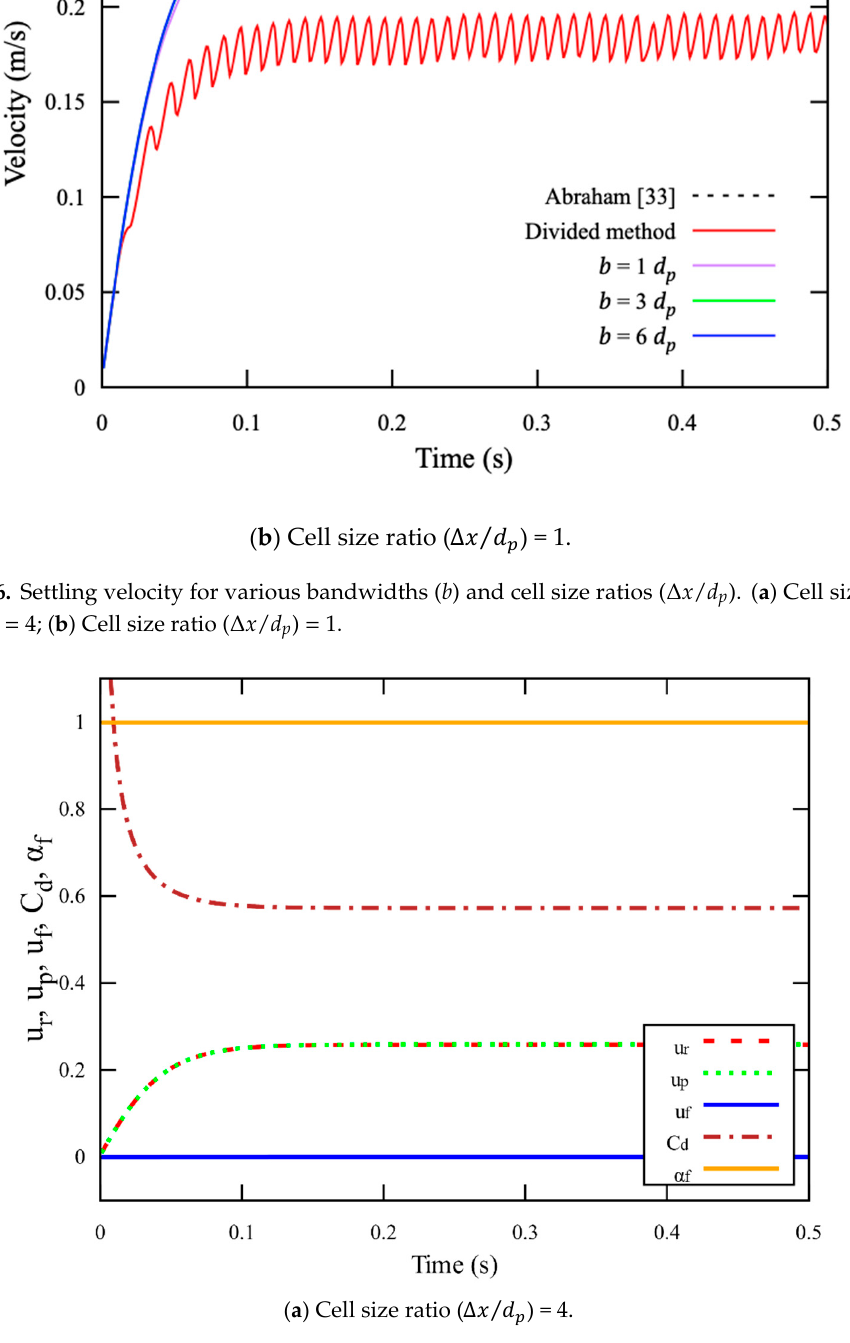
Figure 7. ( a ) Cell size ratio ( ∆(cid:1876) (cid:1856) (cid:3043) ⁄ ) = 4.